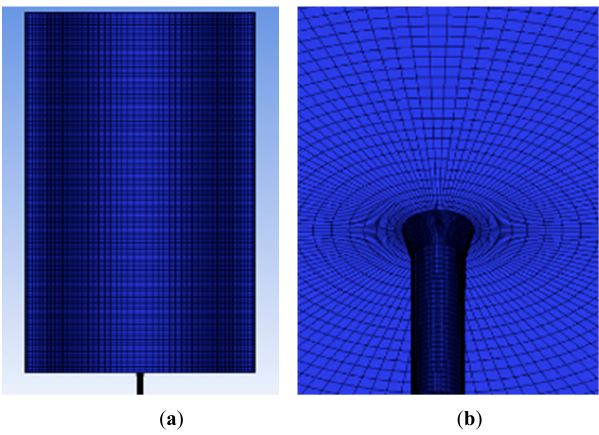
Figure 2. Hexahedral mesh of ( a ) entire computational domain and ( b ) shock